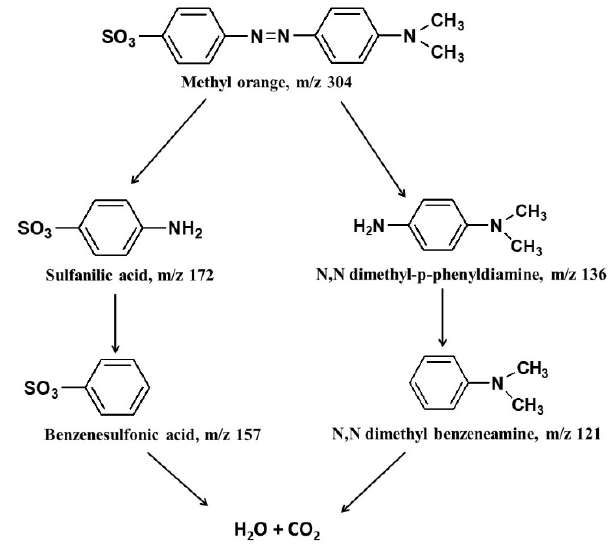
Figure 12. Possible reaction pathway of MO